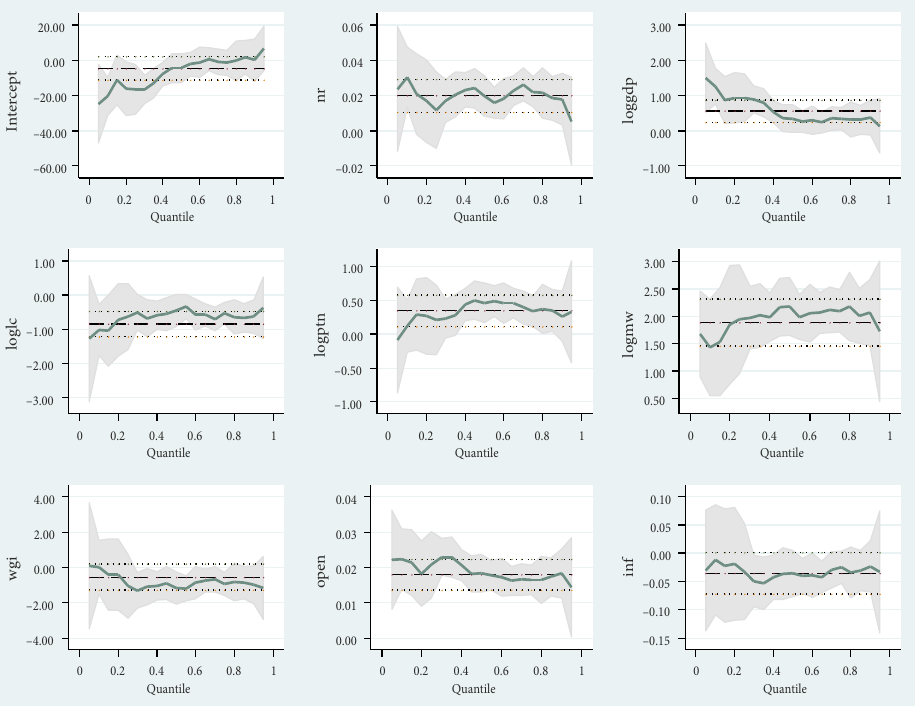
Figure 1. Graphical quantile regression analysis for each determinants of